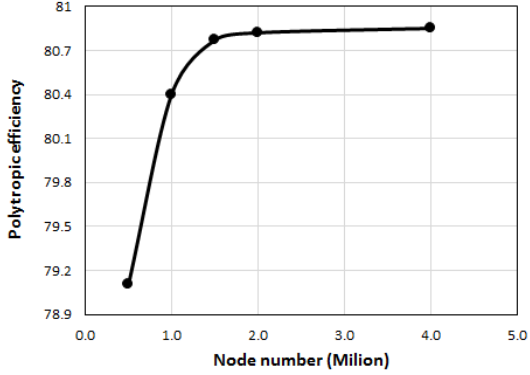
Figure 4 . Polytropic compressor efficiency for the different grid sizes.